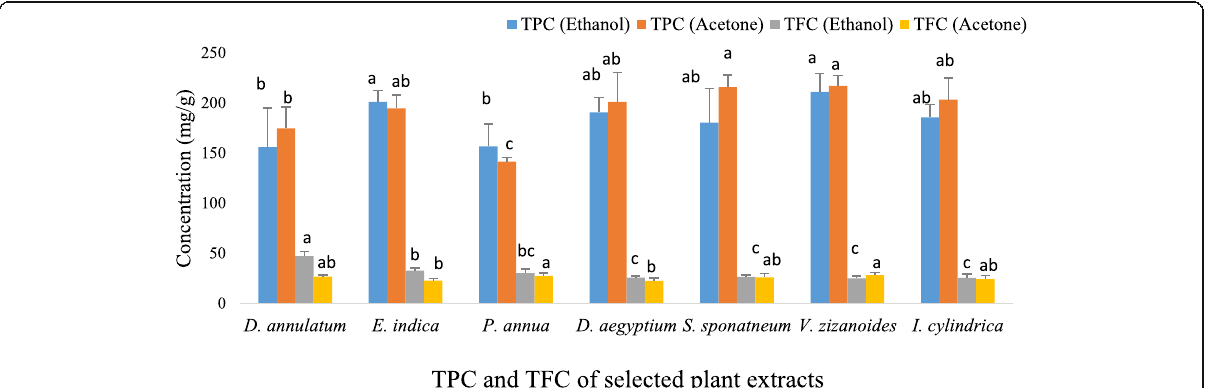
Fig. 1 TPC and TFC in selected plant extracts. Data represents the mean of three replicates and each letter (a-c) indicates significance at P < 0.05